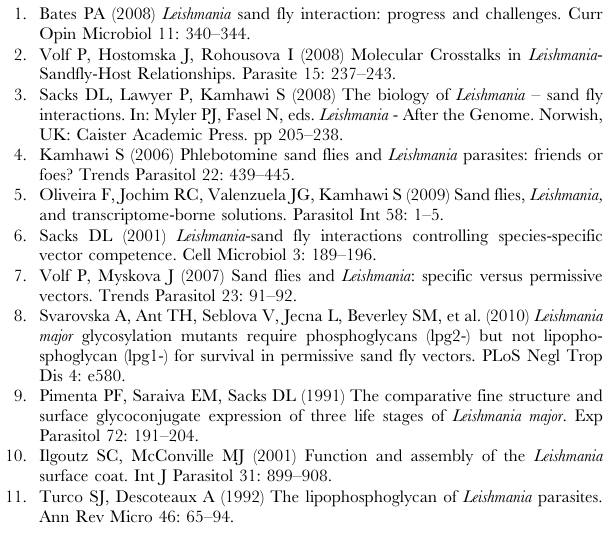
Table S3 Comparative outcomes in P. papatasi Ppap J and P. argentipes Parg IN infections after expulsion of the digested blood meal.